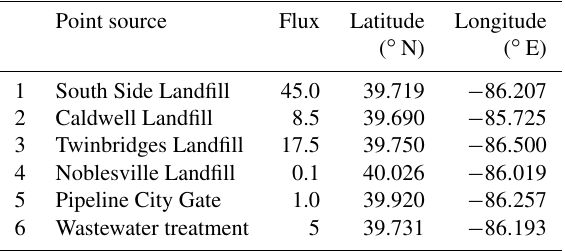
Table 1. Location and estimated methane flux of major point sources in